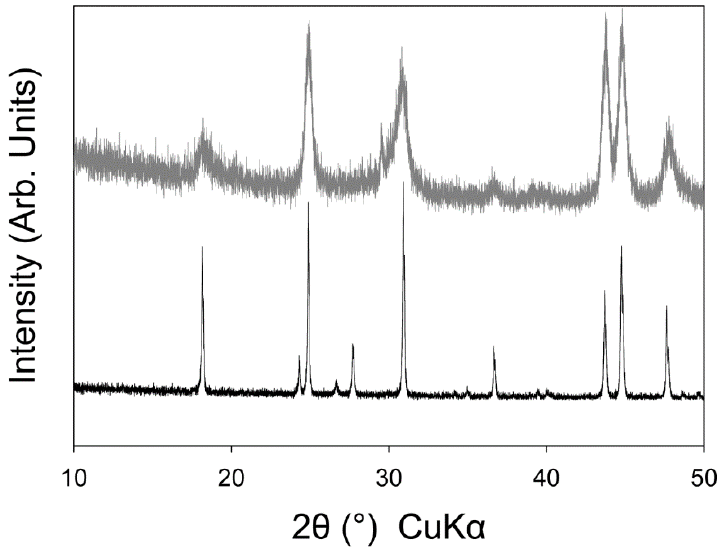
Figure 2. Powder XRD patterns of synthesized bastnäsite-(La) starting material. Top pattern is after washing and drying, bottom pattern is after annealing in the Griggs modified piston cylinder apparatus.